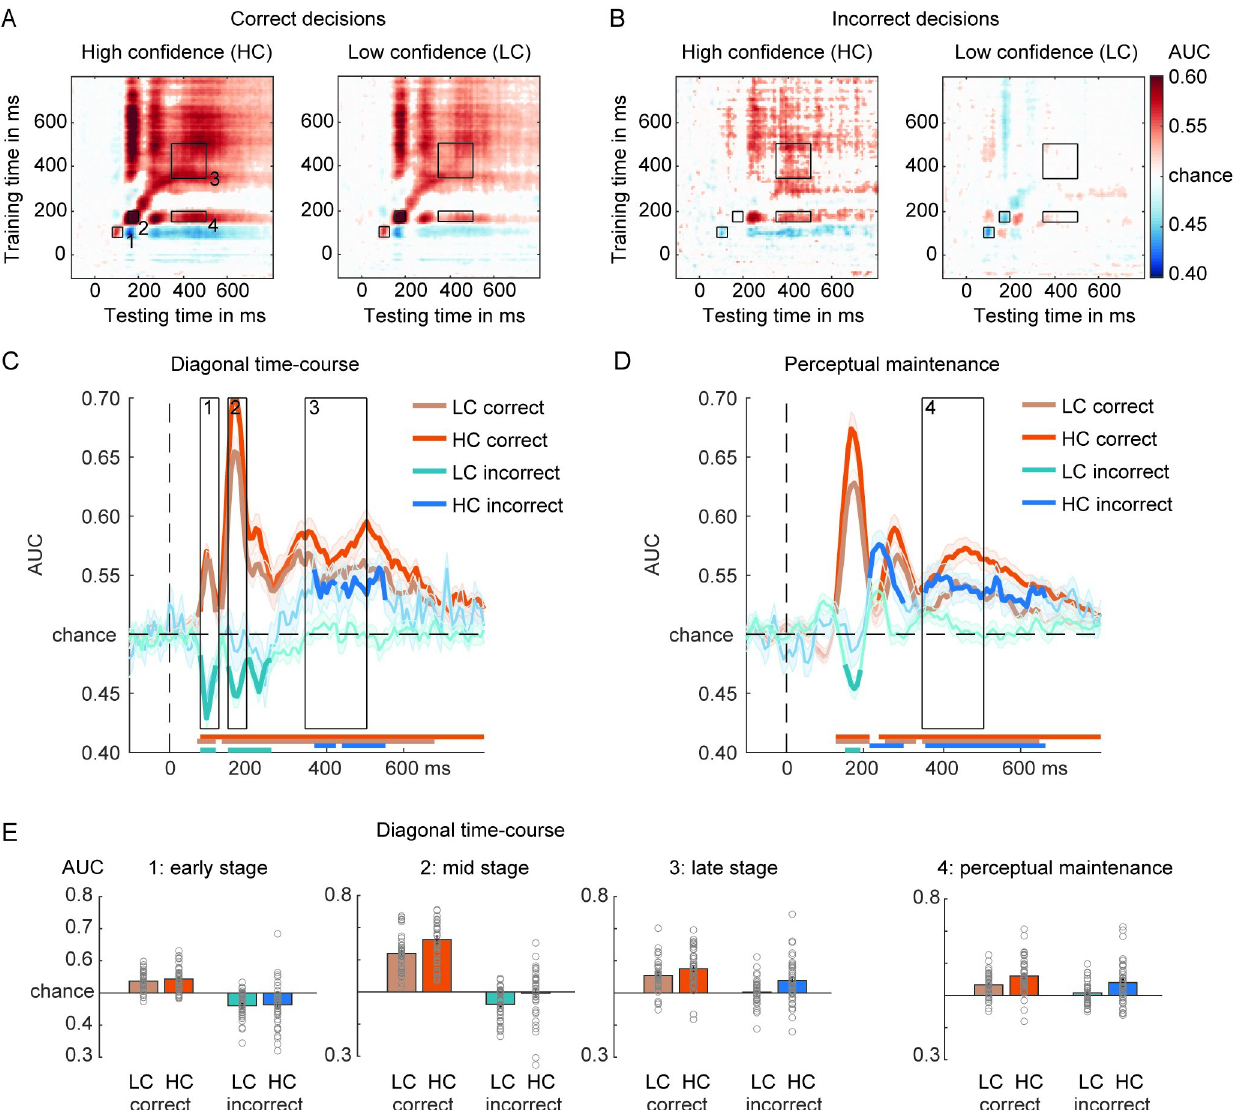
Fig 3. Face/house classification in the main task while training on the decision localizer. ( A ) GAT matrices for correct trials and ( B ) incorrect trials in the main discrimination task (occipital–parietal channels). Trials are separated by confidence—HC and LC—in the decision. ( C ) On-diagonal and ( D ) off- diagonal (perceptual maintenance) time courses of correct and incorrect decisions, separated by confidence. Black boxes indicate the time-windows (early, mid, late) used for averaging the AUC scores. Colored horizontal lines indicate periods of significant decoding with respect to chance. Longer-lasting sensory traces are derived by training a classifier on the time-window 150–200 ms and testing it across the entire time-window (panel D). Classification performance was evaluated at each time point using cluster-based permutation testing (two-tailed cluster-permutation, alpha p < 0.05, cluster alpha p < 0.05, N permutations = 1,000). ( E ) Bar plots show average AUC values for the TOI highlighted in panels (C) and (D). The underlying data and scripts supporting this figure can be found on FigShare (https://doi.org/10.21942/uva.c.6265233.v1). AUC, area under the curve; GAT, generalization across time; HC, high confidence; LC, low confidence; TOI, time-windows of